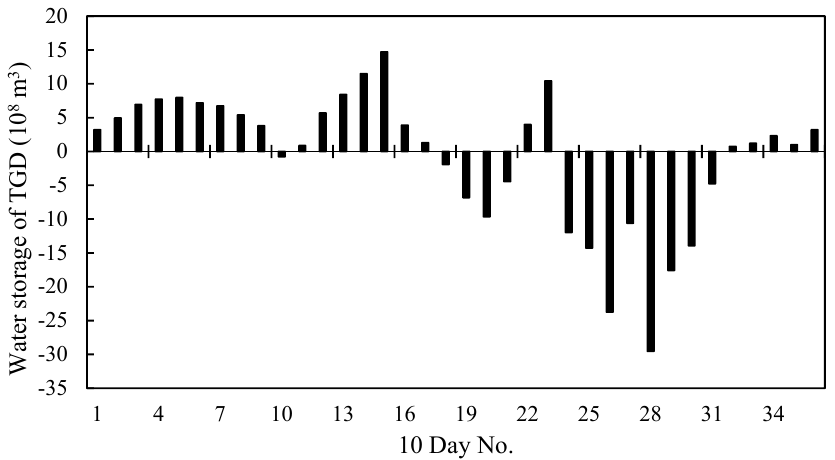
Figure 6. Annual average water storage of TGD (Notes: positive values represent increased drainage, negative values represent water storage).